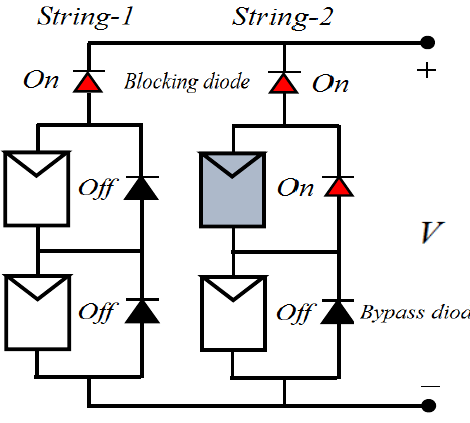
Figure 2. Model of the PV stringstructure.